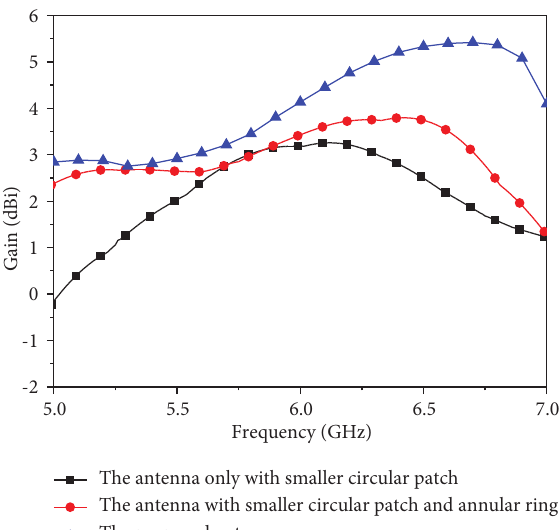
Figure 8: Simulated gain of the antenna without and with annular ring and shorting